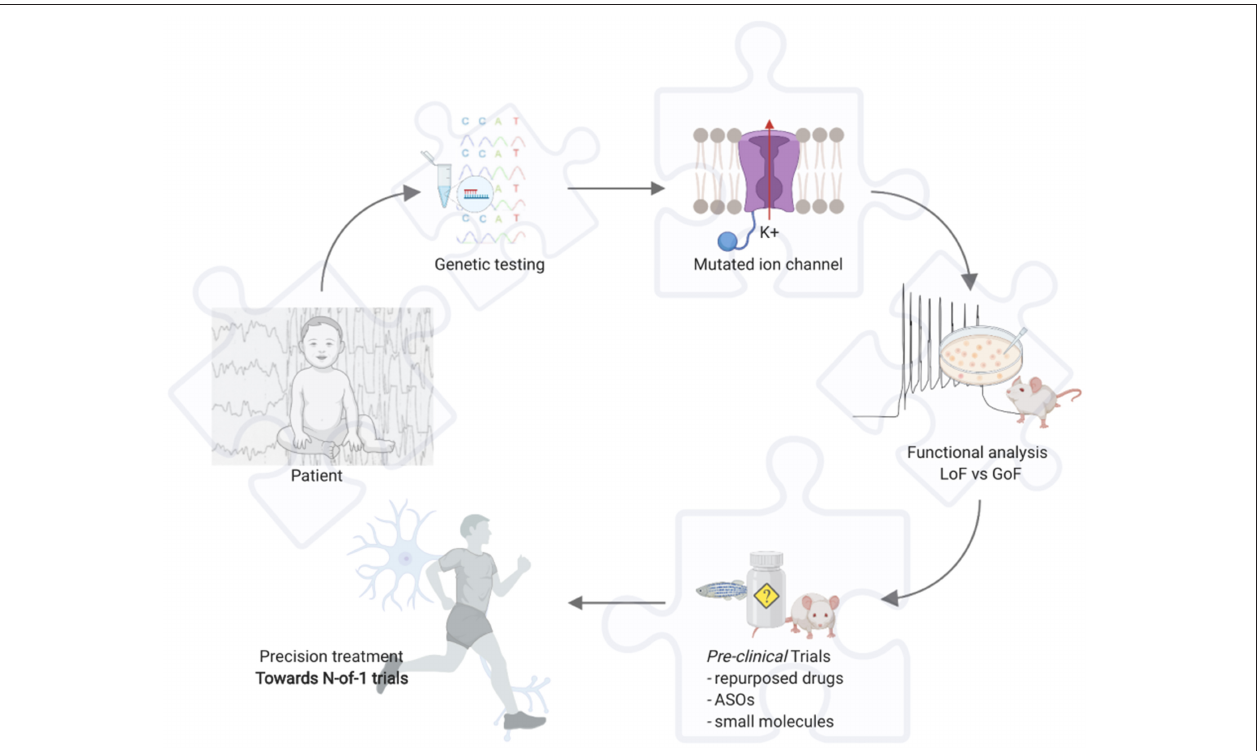
FIGURE 1 | Example for precision medicine in epileptic channelopathies. Toward N-of-1 trials. Created with BioRender.com. ASOs, antisense oligonucleotides; GoF, gain of function; LoF, loss of